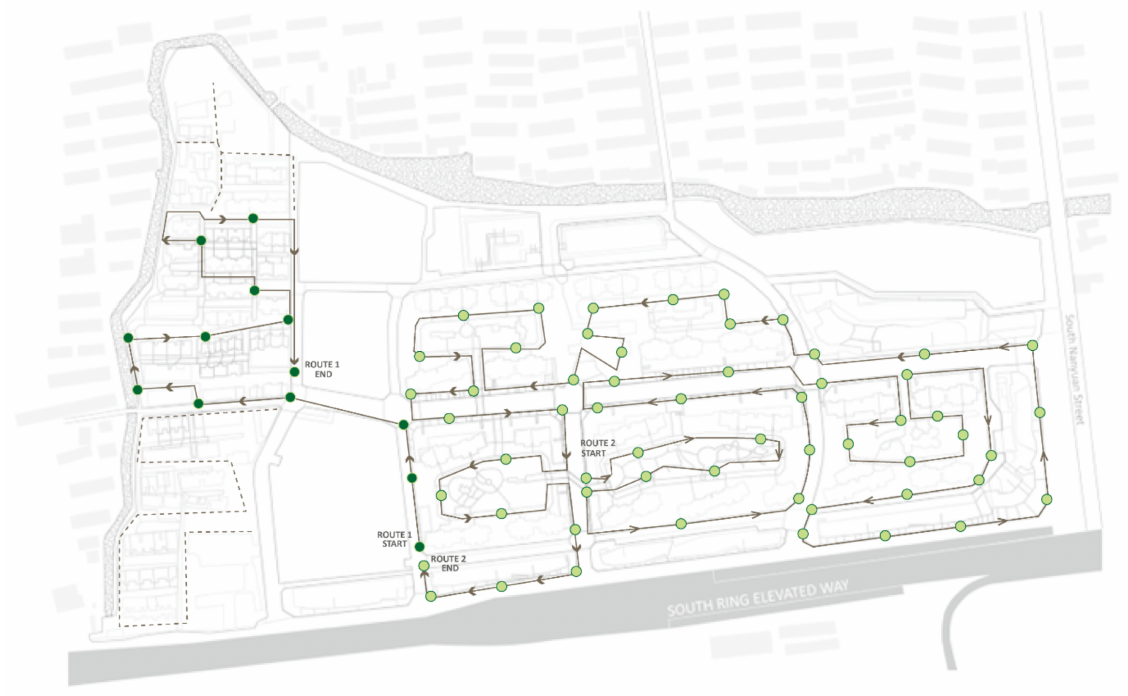
Figure 4. Image data collection routes and the 54 navigation